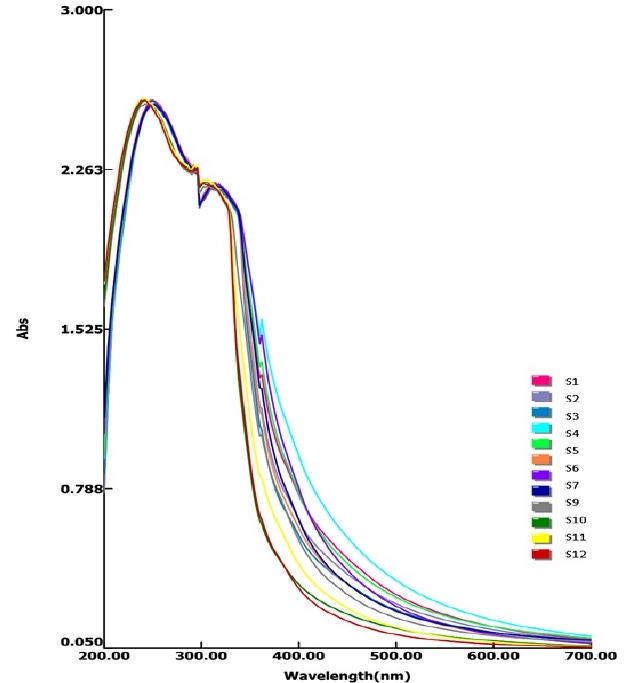
Figure 1. The absorbance of treated oil.